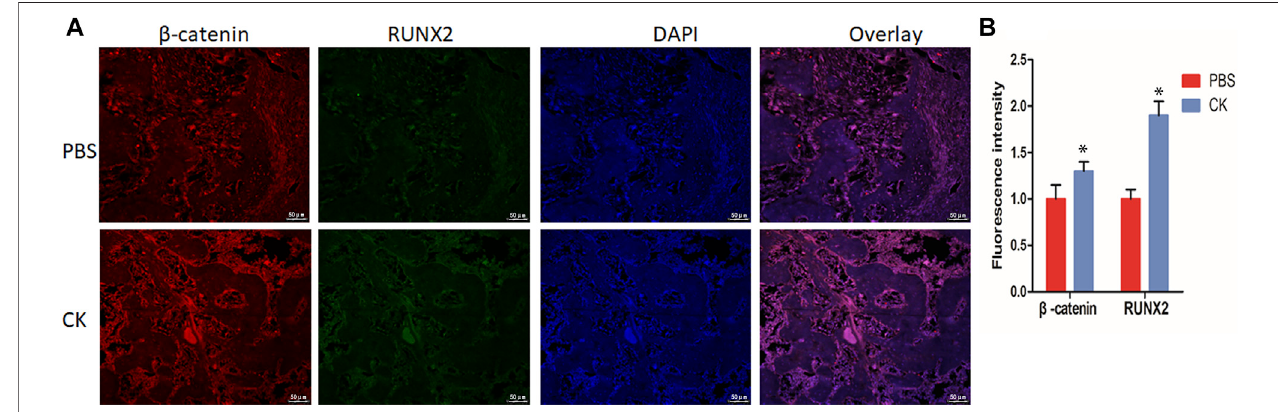
FIGURE 6 | CK up-regulated β -catenin and Runx2 in fracture callus. (A) Immuno fl uorescence staining images of β -catenin and Runx2 in PBS and CK groups and (B) Quanti fi cation of the immuno fl uorescence density of β -catenin and Runx2 offracture calluses in PBS and CK groups, Scale bars = 50 μ m, * p < 0.05, compared with the PBS group, n =